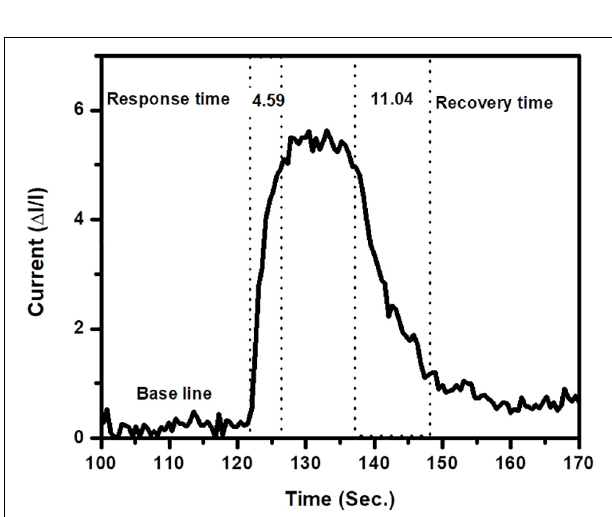
FIGURE 10 | Standard error bar at SO 2 gas concentration varies from 20 to 4